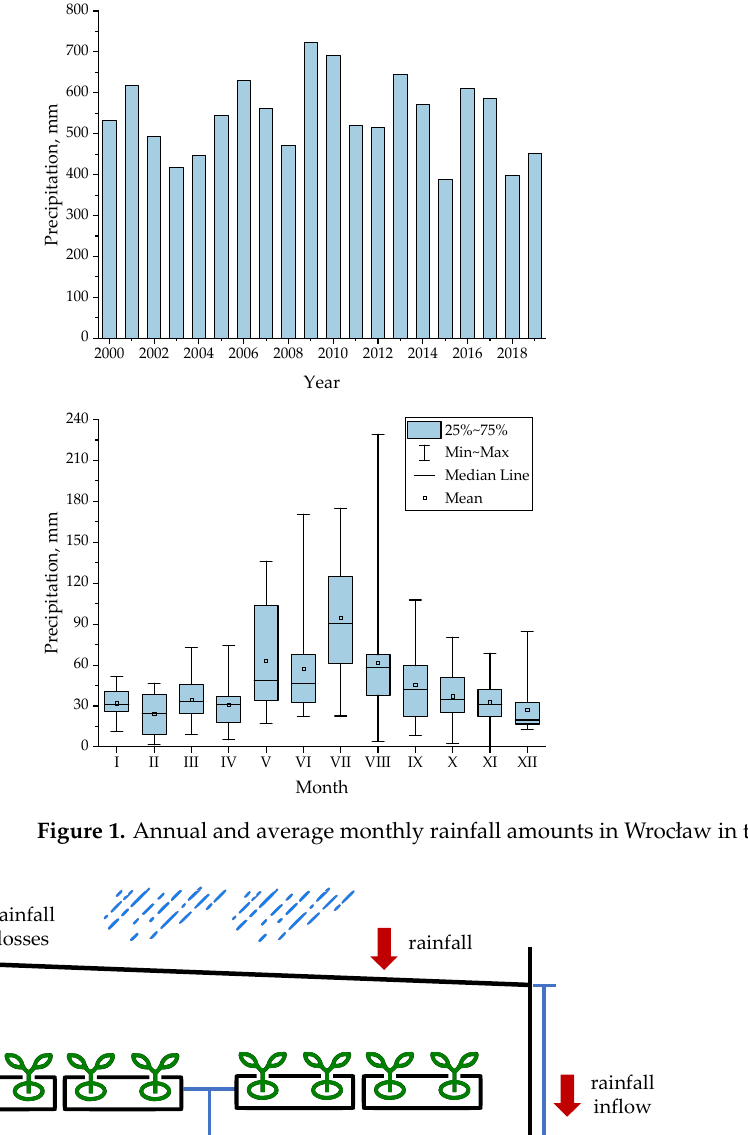
Figure 2. The diagram of the water flow in the rainwater harvesting system.